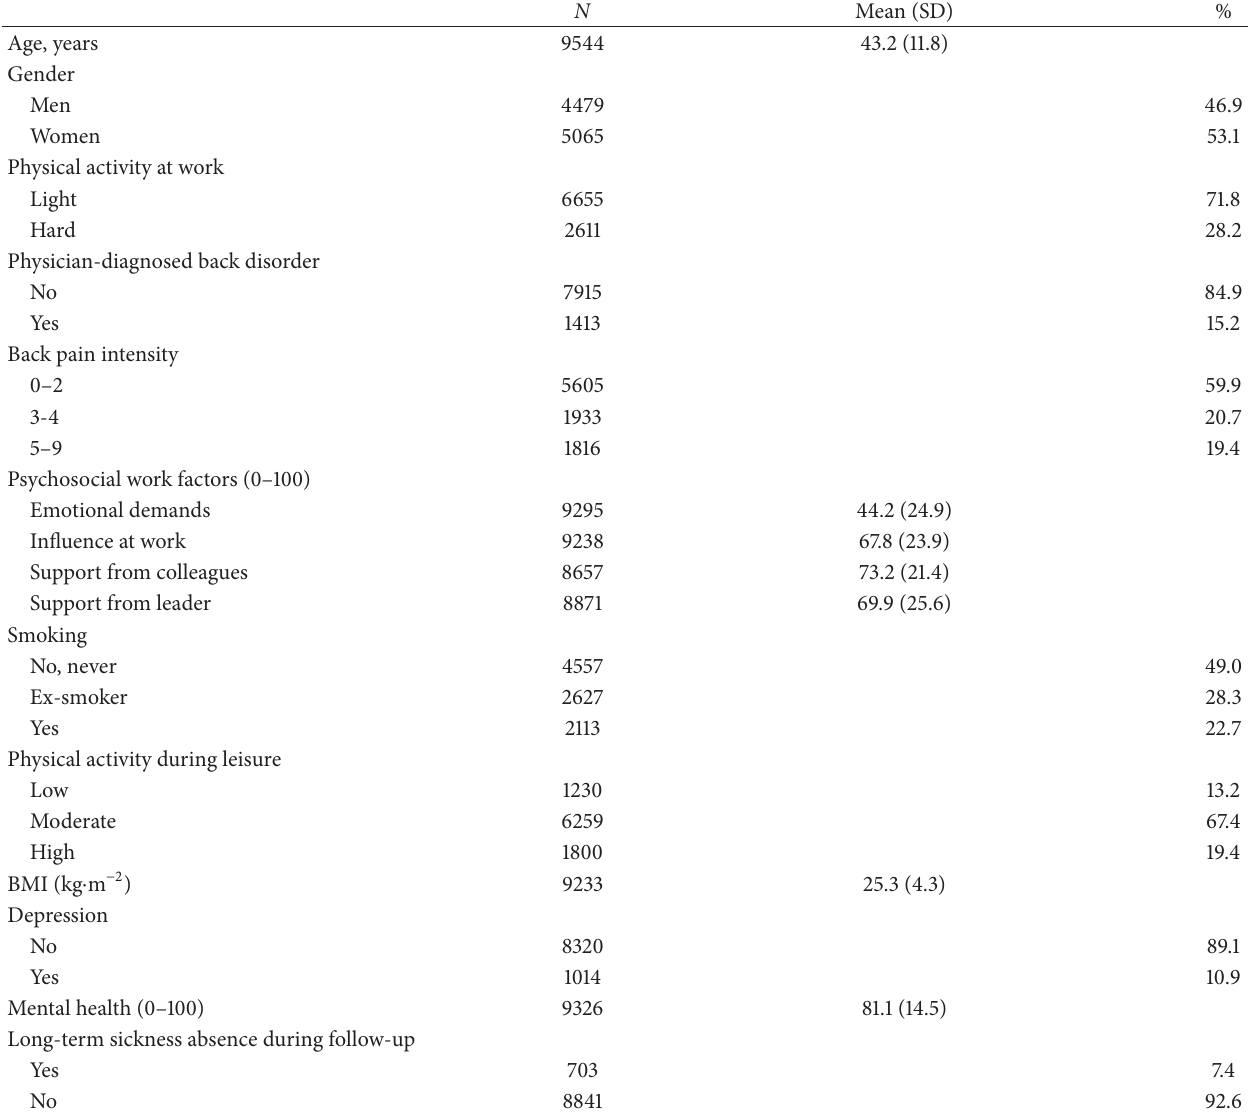
Table 1: Description of the study population at